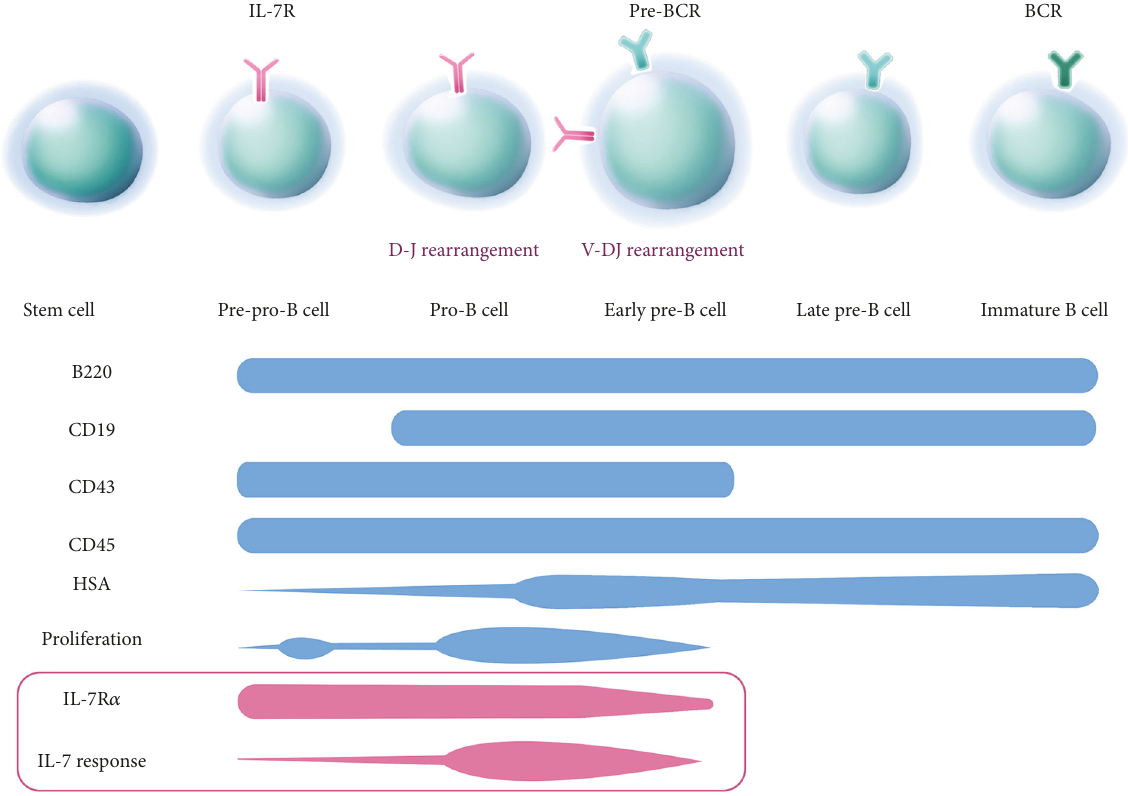
Figure 3: Schematic of B lymphopoiesis in the bone marrow. The presence of various cell-surface markers is indicated in parallel with each stage in the development of B cells. Among these, IL-7 is important in early B cell di ff erentiation because it promotes the commitment of CLP to the B-lineage. It also acts in concert with transcription factors to regulate immunoglobulin gene rearrangement in the pro-B cell and early pre-B cell stages. Early pre-B cells express IL-7R α until V-DJ rearrangement is complete. Successfully rearranged cells then proliferate in response to IL-7 and other cytokines.